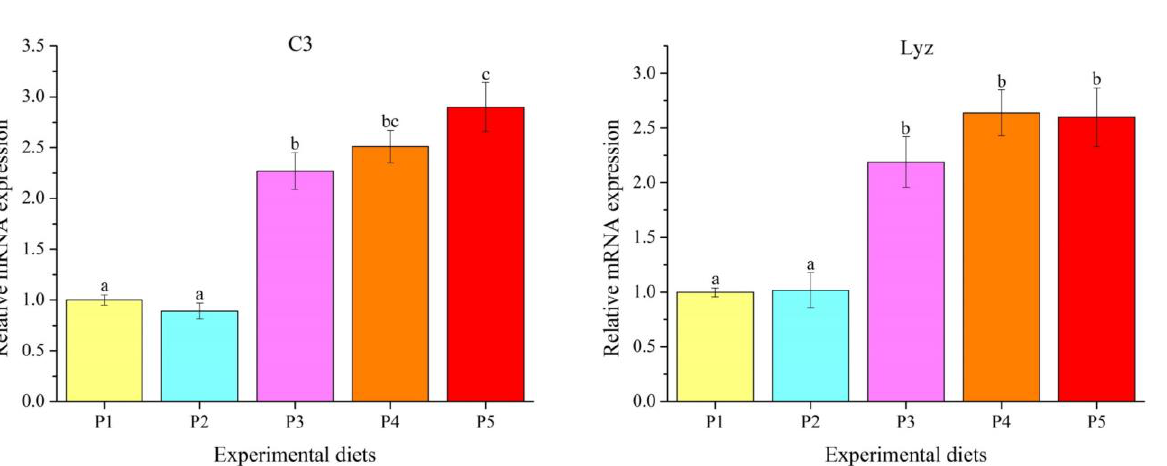
related genes in the liver (Figure 6) ( p < 0.05). Complement 3 ( C3 ) and lysozyme ( Lyz ) levels. Compared with the P1 and P2 diets, C3 and Lyz expressions were obviously elevated in the P3, P4 and P5 diets ( p < 0.05).